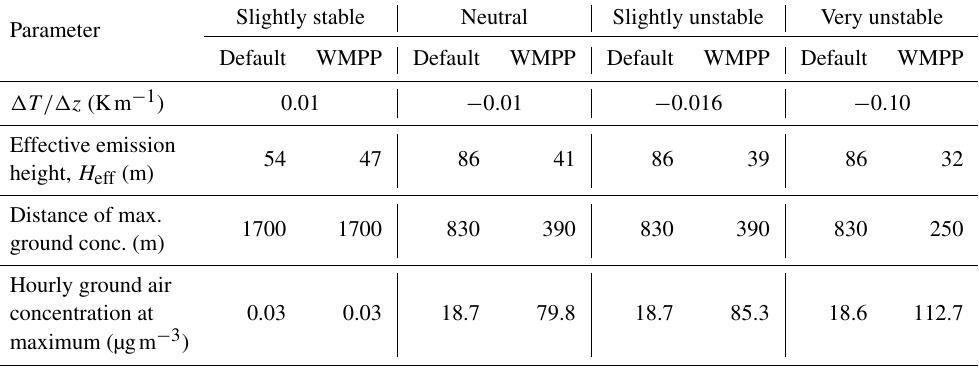
Table 4. Test of the point source dispersion of SO 2 (handled as an inert tracer) for different atmospheric stability conditions in flat terrain at a wind speed of 1ms − 1 . Hourly concentration is given at the location where the maximum is found for the 5d average within a radius of 2.0km around the point source. Parameterization of point source: exhaust gas temperature: 20 ◦ C; stack height: 10m; exit velocity: 5ms − 1 ; stack radius: 0.5m (circular opening). Emission rate: 1gs − 1 . The default is the standard parameterization in